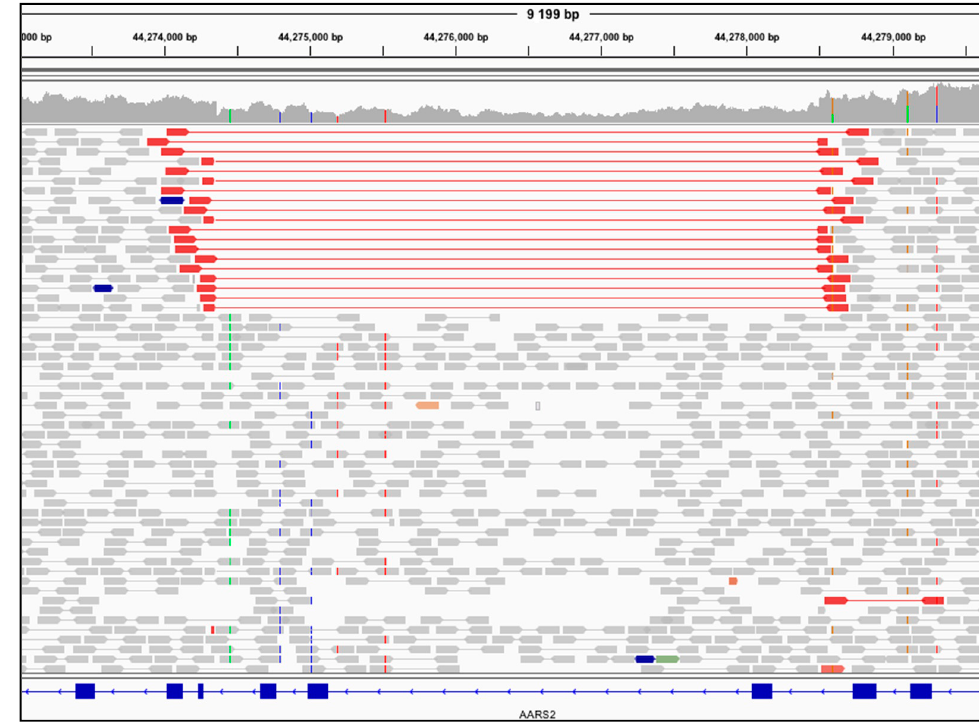
Figure 2. GS detects an intragenic nuclear DNA deletion in AARS2 in P2. IGV coverage plot shows ≈ 50% fewer reads in the region spanning the deletion. The read pairs that are colored red are flanking the deletion.